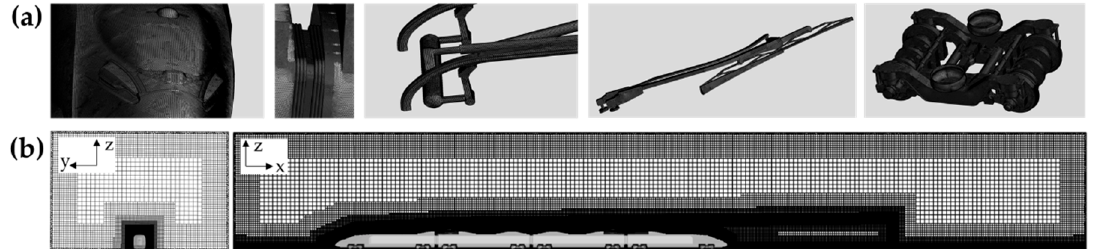
Figure 3. Target train model (HEMU-430X) and its main parts.